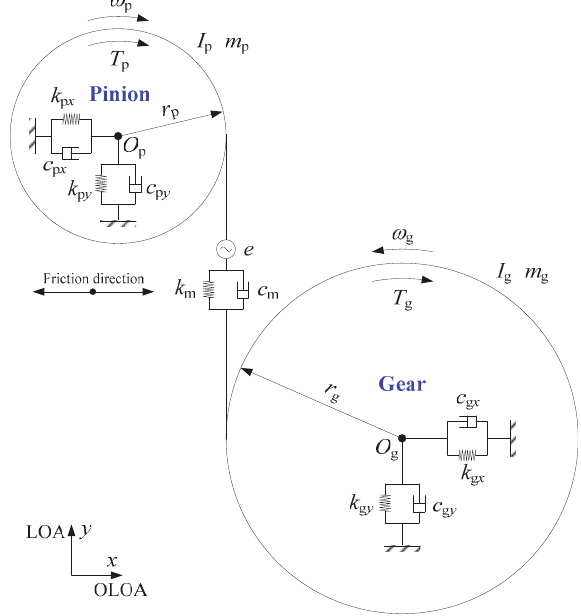
Figure 2. Nonlinear dynamic model of a spur gear transmission.